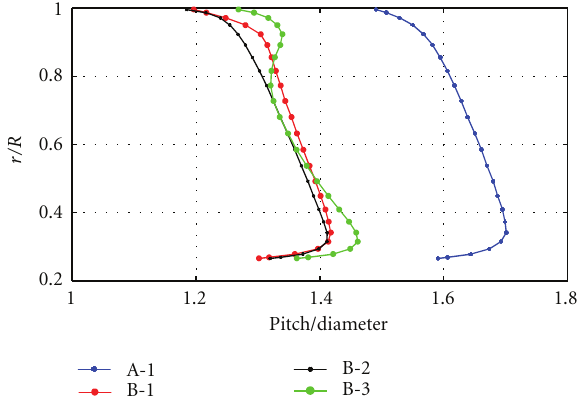
Figure 21: Pitch/diameter, fore propeller.